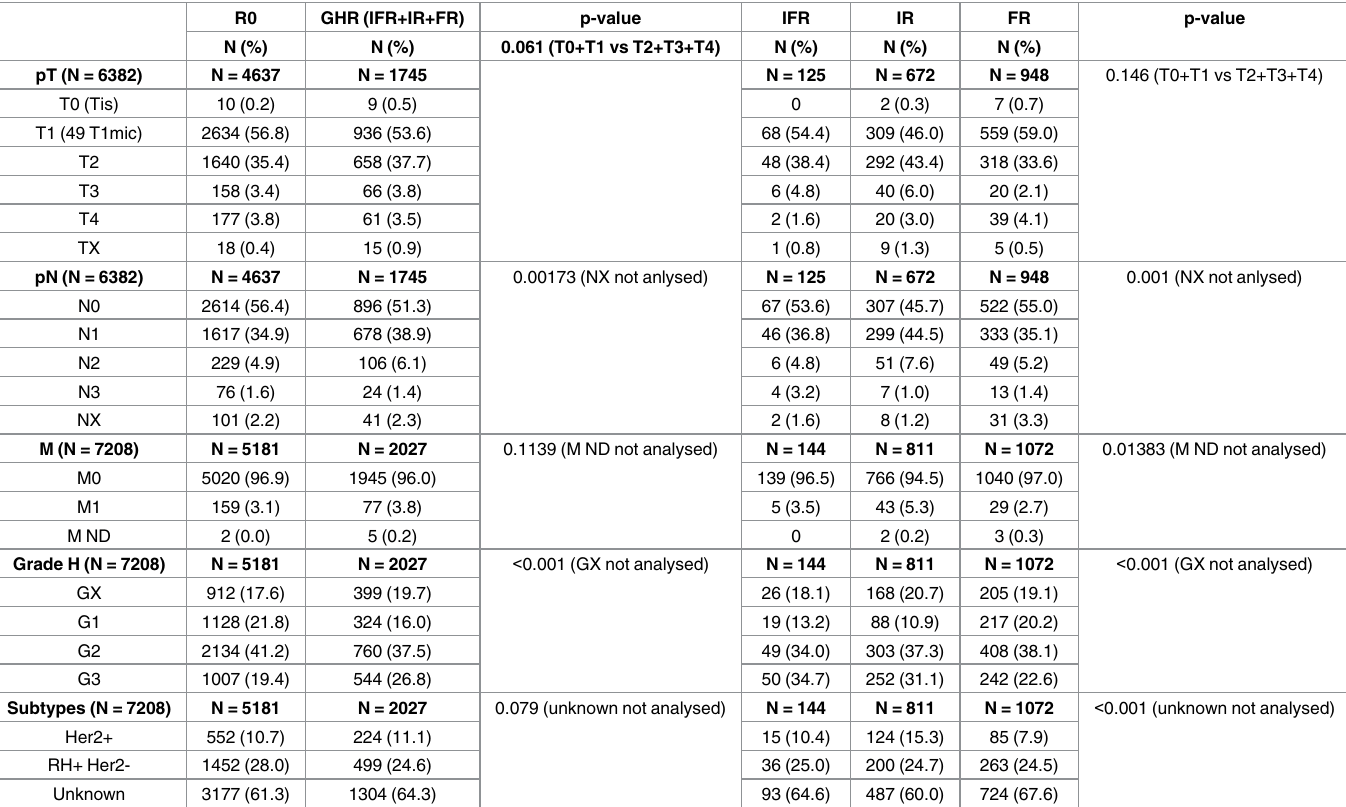
Table 4. Description of the TNM, histological subtype and grade of the evaluable patients, excluding those TN patients. Only pathological T and N were